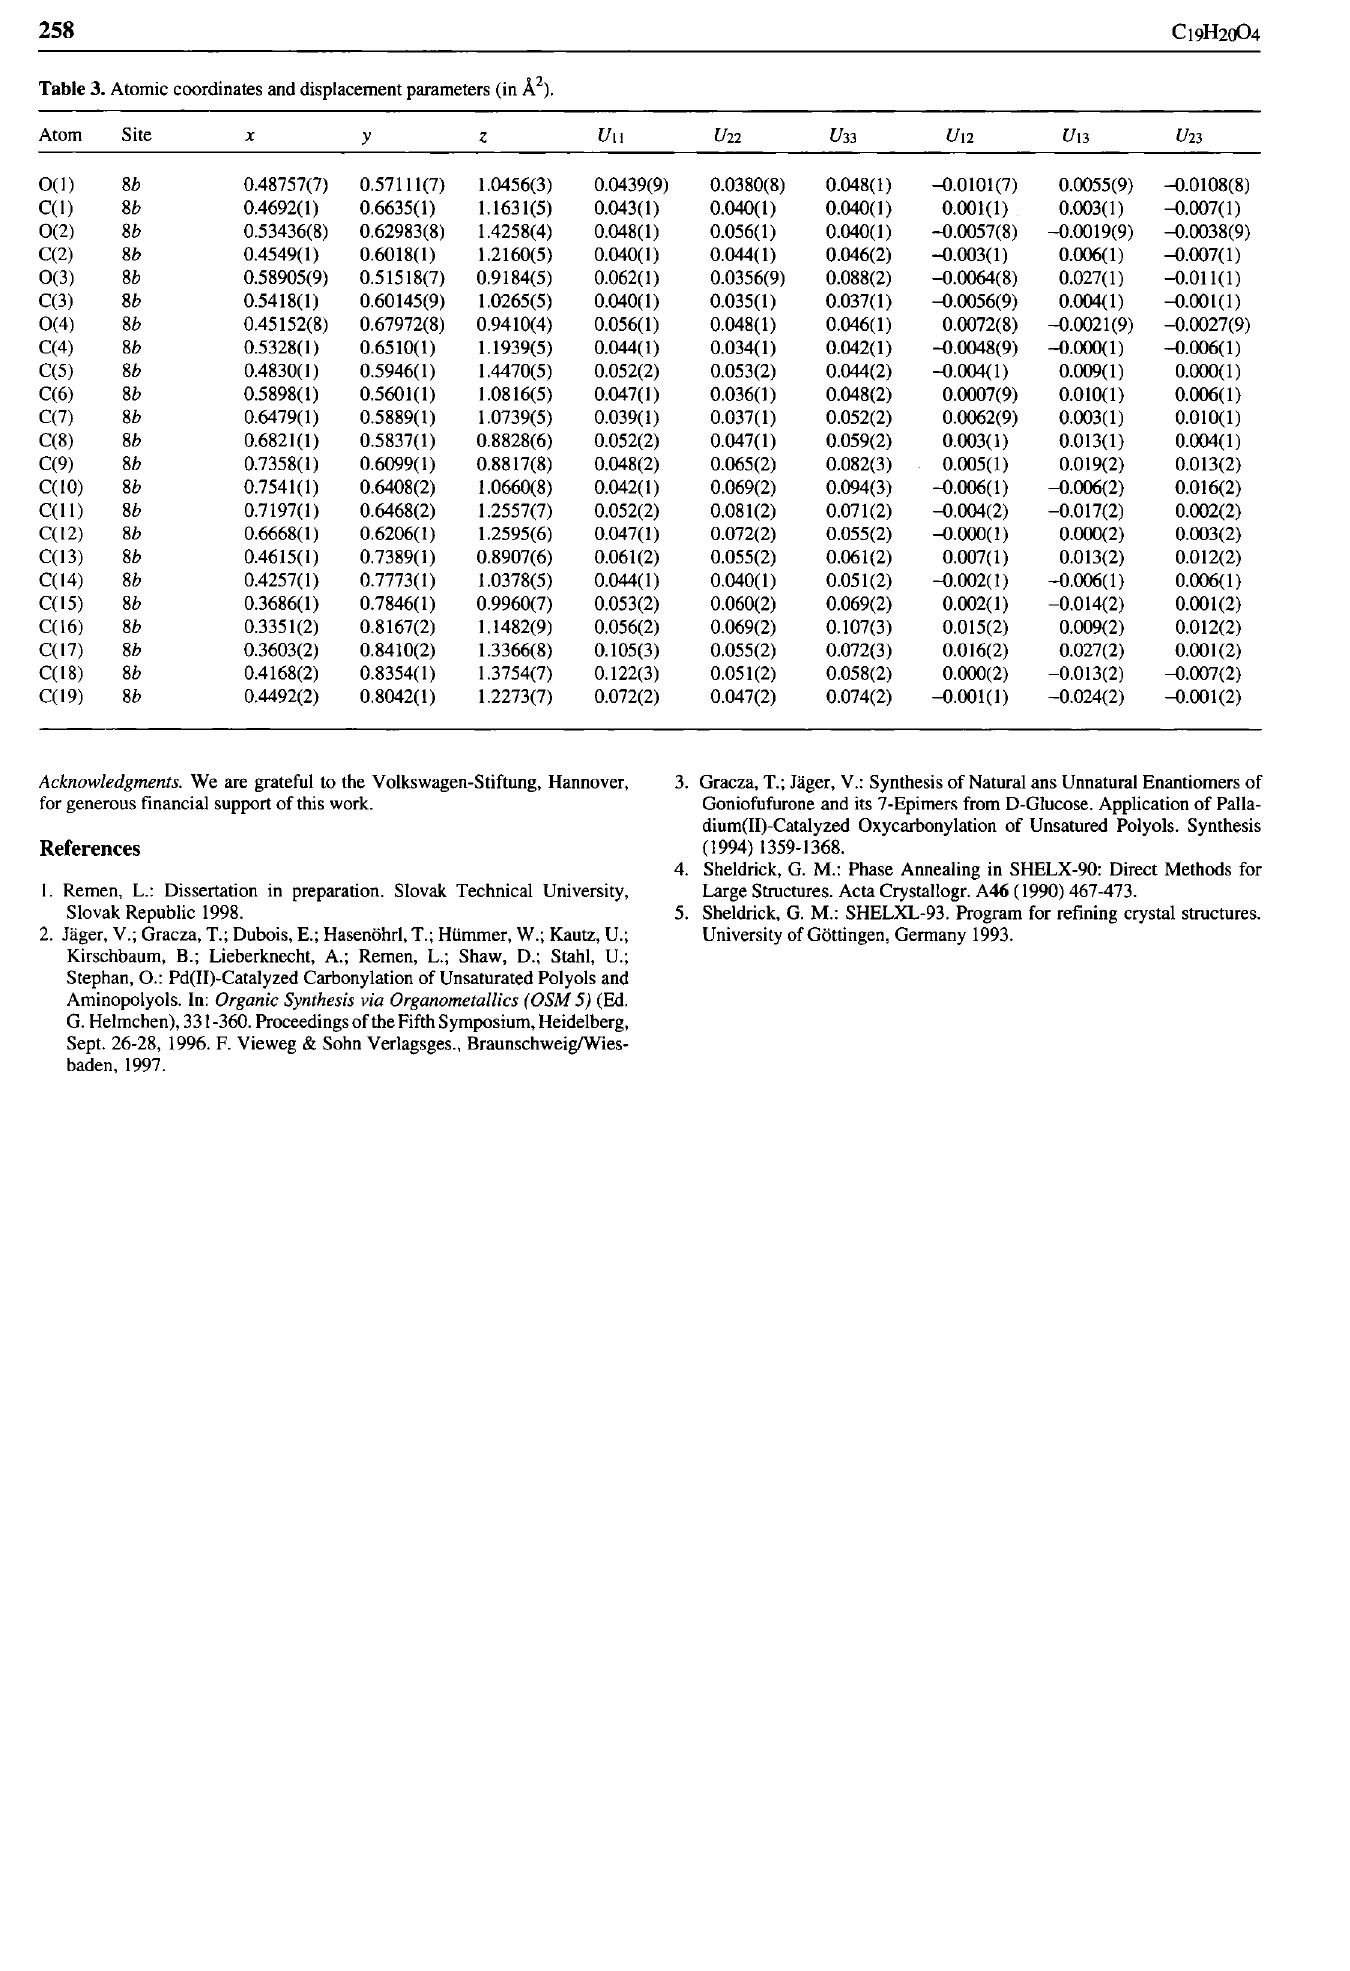
Table 3. Atomic coordinates and displacement parameters (in Ä 2